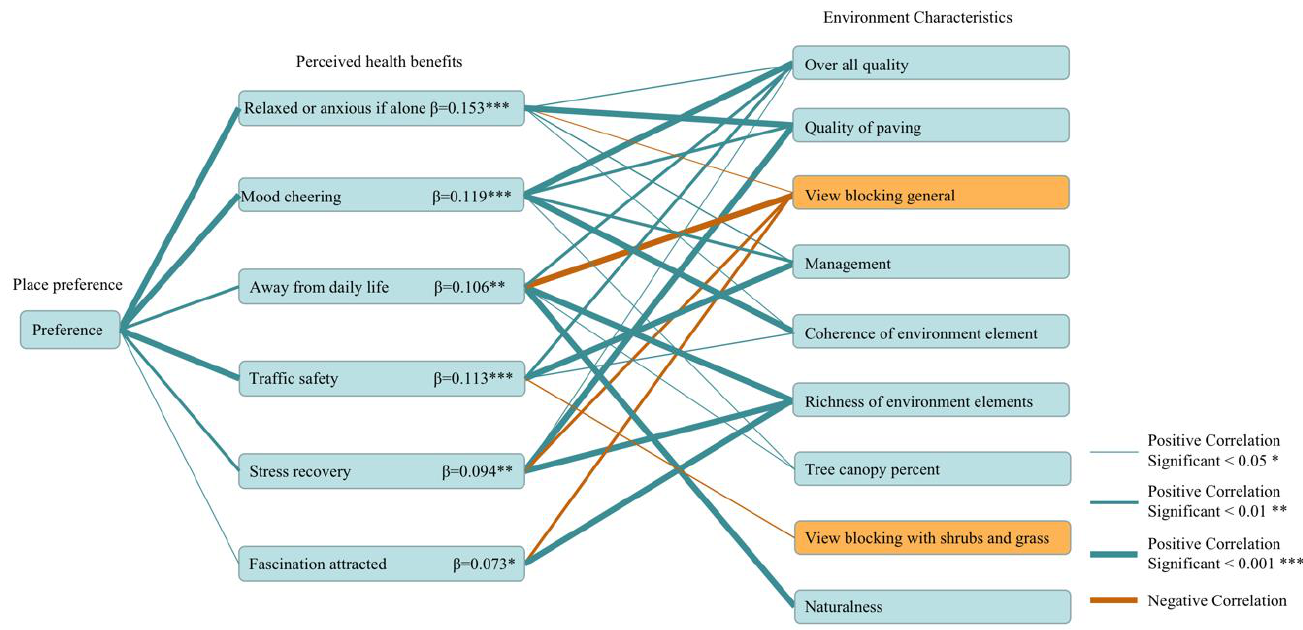
Figure 6. Direct correlation of place preference, perceived health benefits, and environment characteristic.